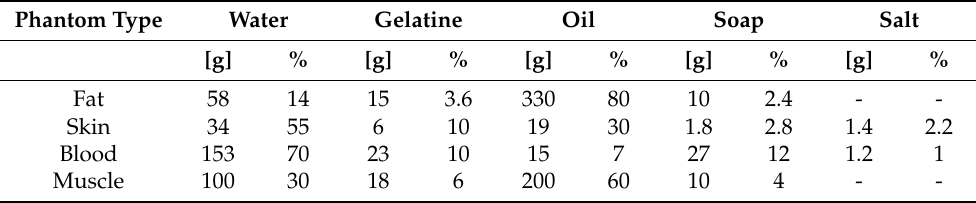
Table 1. Materials concentration for the different tissue-mimicking phantoms. Phantom